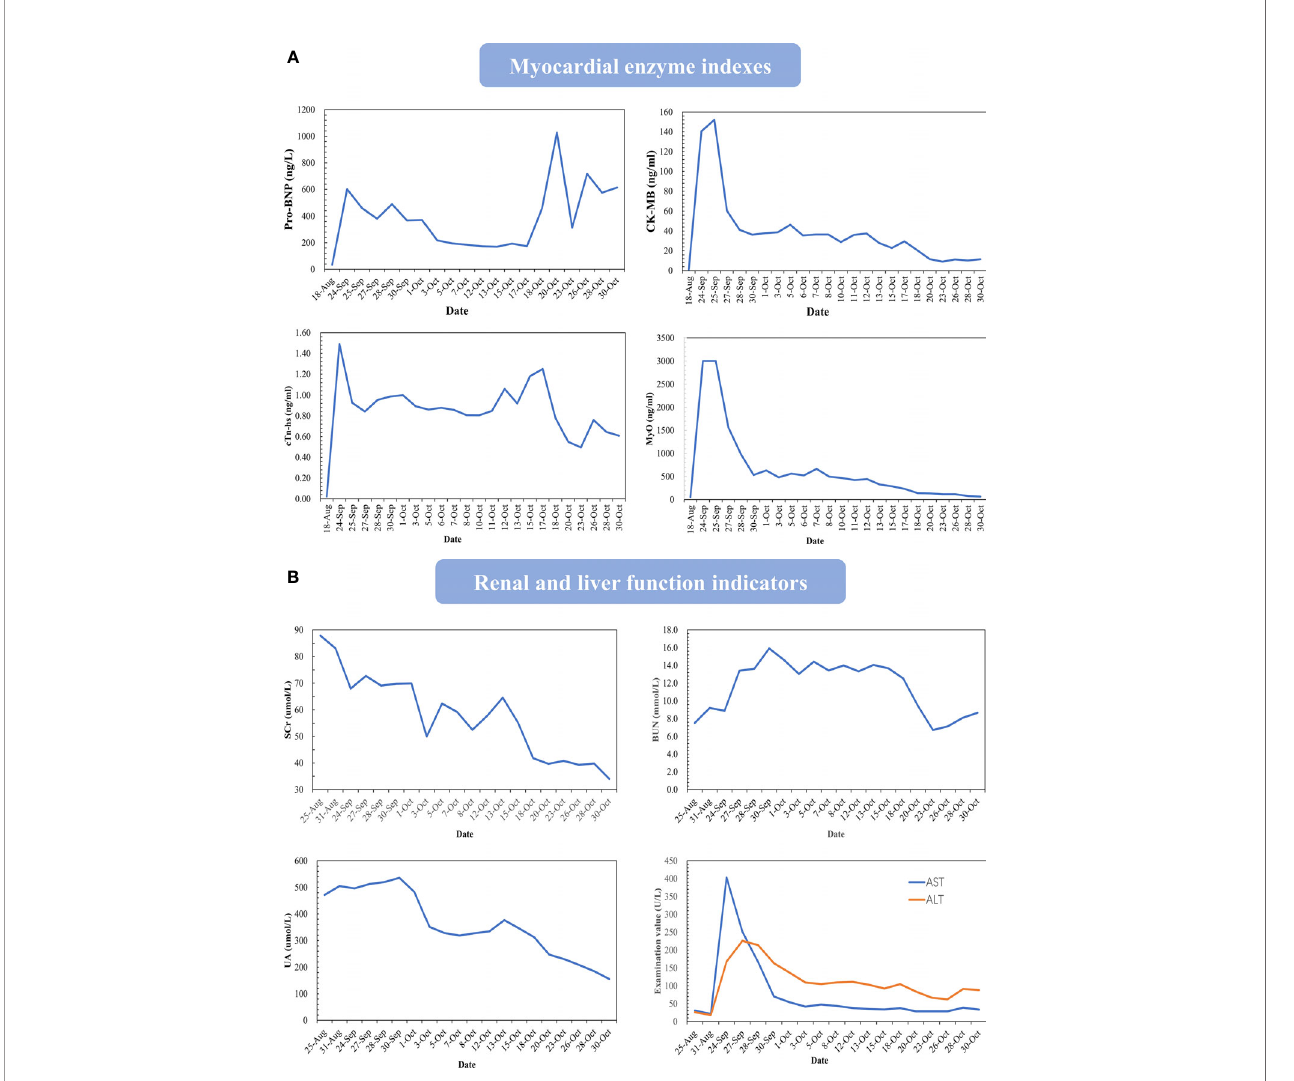
FIGURE 3 | Changes in important indicators during the course of the disease. Changes in myocardial enzymes (A) , renal function and liver function (B) . Take the value of the routine examination before the onset as the